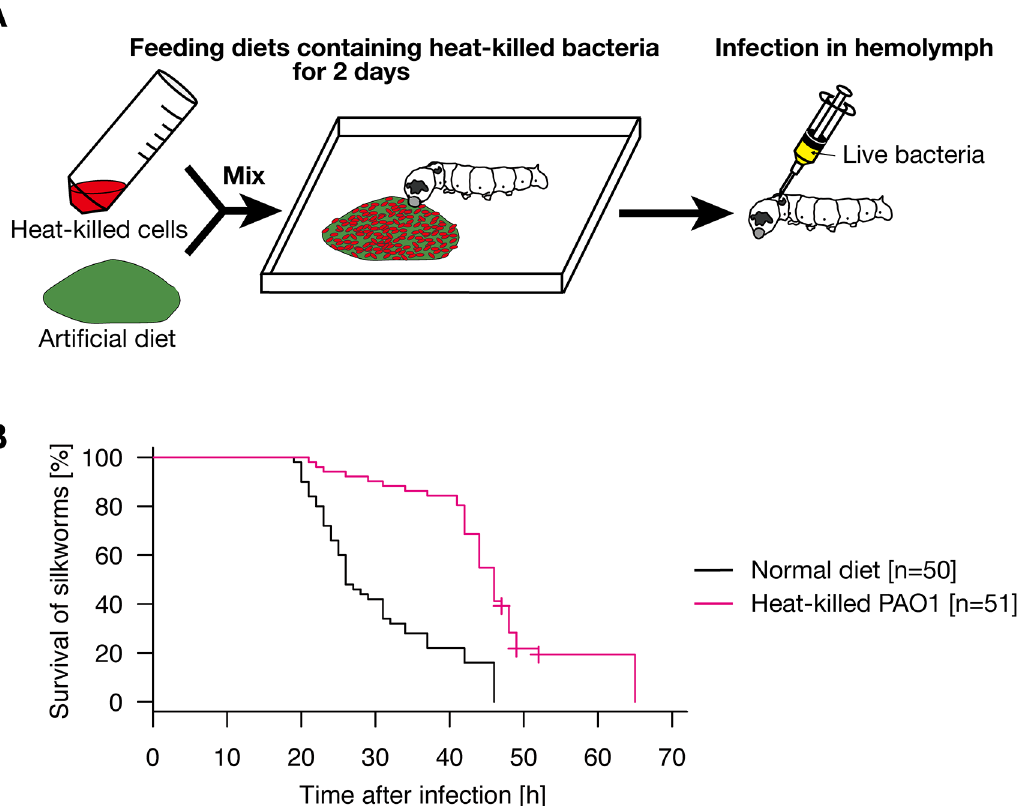
Fig 1. Resistance of silkworms orally administered heat-killed P . aeruginosa cells against P . aeruginosa infection. A. Experimental scheme of the study. Heat-killed bacterial cells were mixed with artificial diet and administered to silkworms for 2 d. Live bacteria were then injected into the silkworm hemolymph. B. Silkworms were fed a diet containing heat-killed P . aeruginosa cells (heat-killed PAO1 diet, n = 51) or a normal diet (n = 50) for 2 d and then injected with P . aeruginosa . Results from five independent trials (S1 Table, exp.1-3 and 5 – 6) were combined into a single analysis. The combined survival curve is shown in the figure. Survival of silkworms fed the diet containing heat-killed P . aeruginosa was significantly higher than that of silkworms fed the normal diet (p = 4.59E-11). None of the mock-infected silkworms died (S1 Fig).